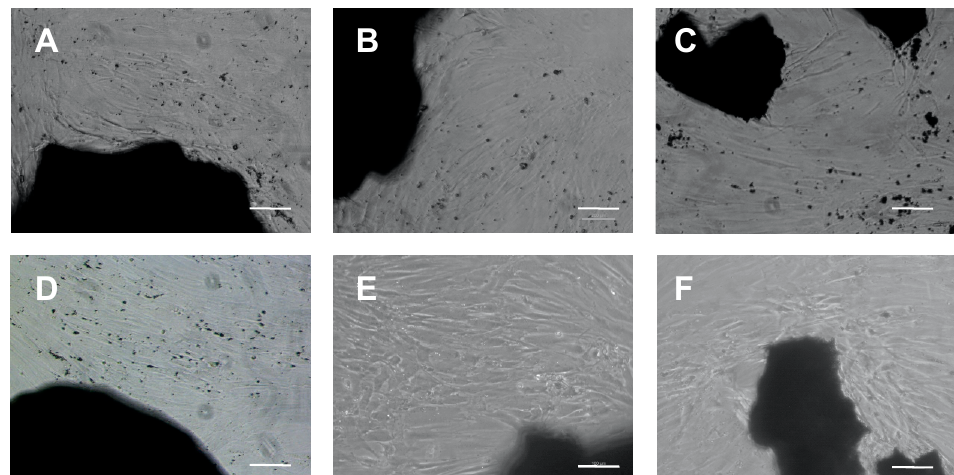
Figure 3. Direct biocompatibility assay: microphotographs of primary human osteoblasts cultured in the presence of 3 mg/mL ( A , D ) hydroxyapatite (HA), ( B , E ) Sr-substituted HA (SrHA) or ( C , F ) Magnesium, strontium-substituted HA (MgSrHA) granules. Cells were observed at phase contrast after ( A – C ) three days or ( D – F ) seven days of culture. Magnification: 10 X. Bar = 20 μ m.